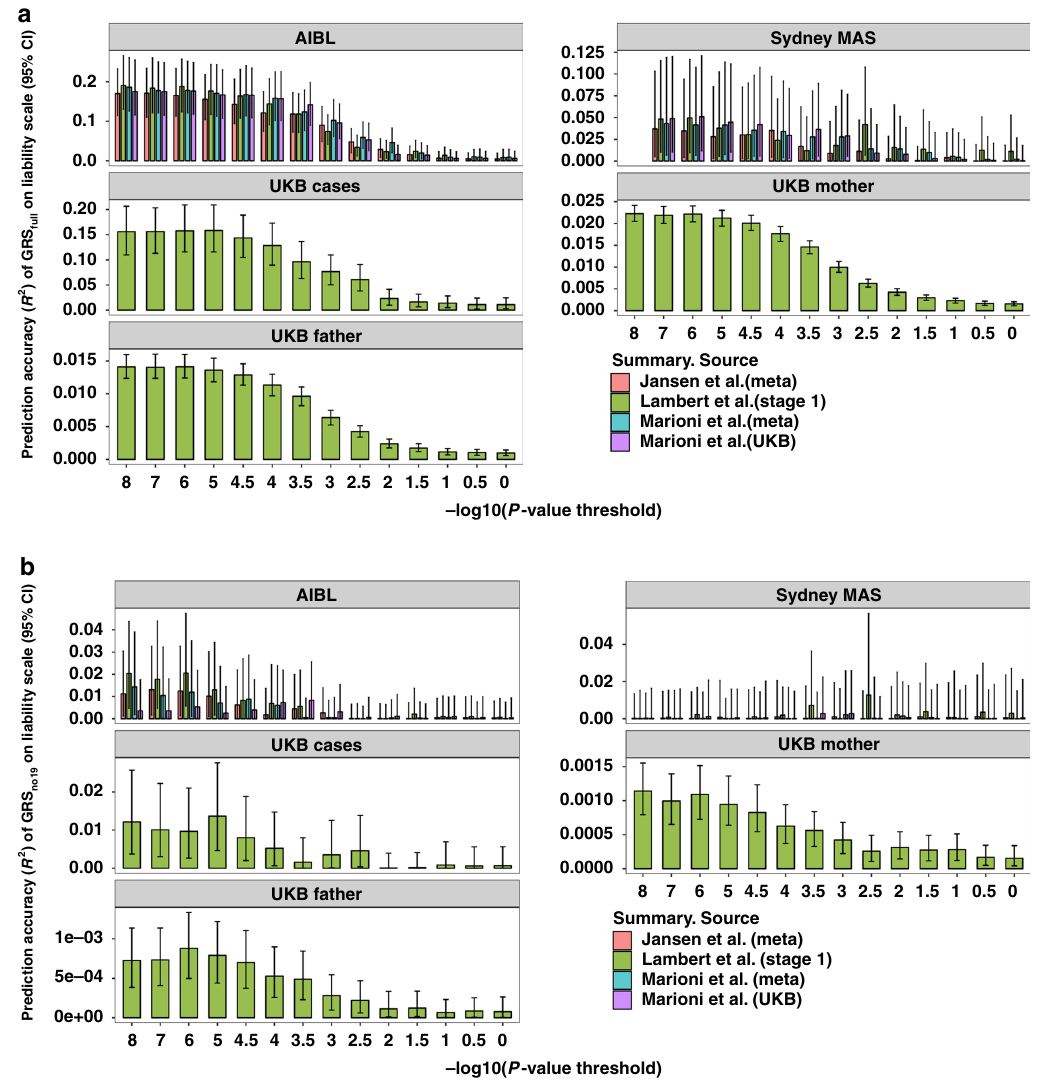
Fig. 2 The prediction performance of genetic risk score (GRS) in different datasets. a The prediction accuracy of GRS full based on SNPs selected using different P- value thresholds. GRS full was calculated based on 1,056,154 HapMap3 SNPs and two APOE SNPs. b The prediction accuracy of GRS no19 based on SNPs selected using different P- value thresholds. GRS no19 is calculated based on HapMap3 SNPs excluding SNPs from chromosome 19, to avoid contamination with APOE . Prediction results on samples from UKB cases and UKB parents are based on summary statistics from Lambert et al. 12 (stage 1) only. The error bars represent 95% con fi dence interval, and the con fi dence interval was calculated based on 1000 bootstrap replications 59